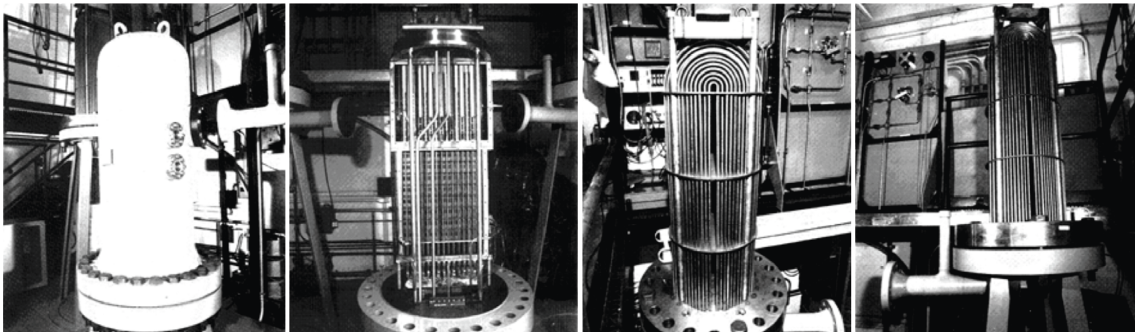
Figure 1: Westinghouse 1/7th scale natural circulation test